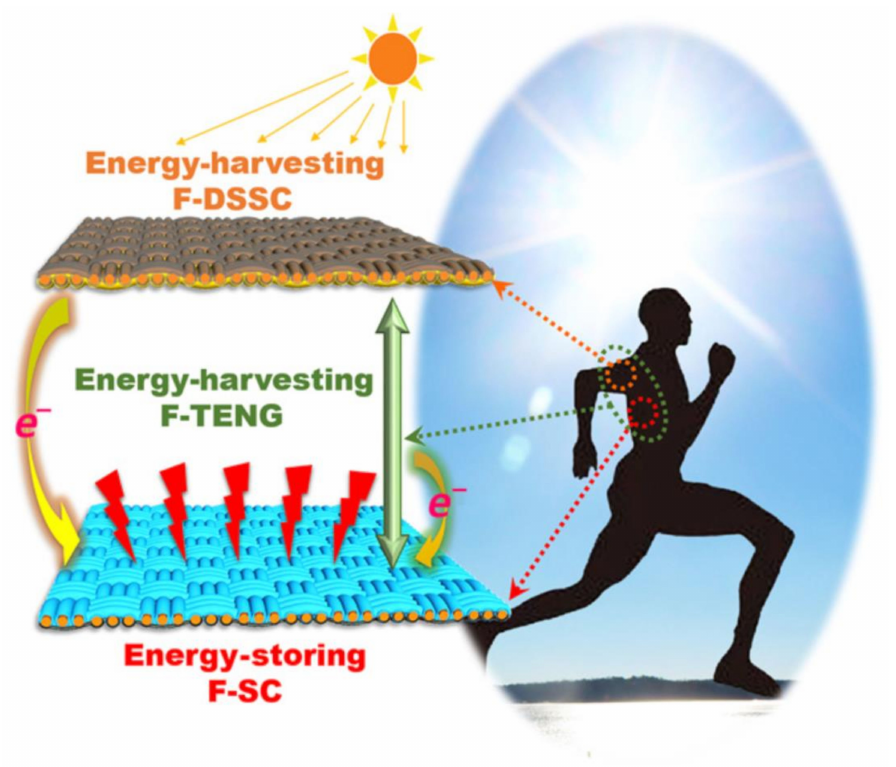
Figure 4. Schematic of the fiber-based, self-charging power system developed by Wen et al. [134], which is composed of an F-TENG, an F-DSSC energy harvesting fabric, and an F-SC energy-storing fabric. F-TENG: fiber-shaped triboelectric nanogenerator; F-DSSC: fiber-based, dye-sensitized solar cell; F-SC: fiber-based supercapacitor (adapted from [134] Courtesy of Dr. Zhong Lin Wang, with permission from the